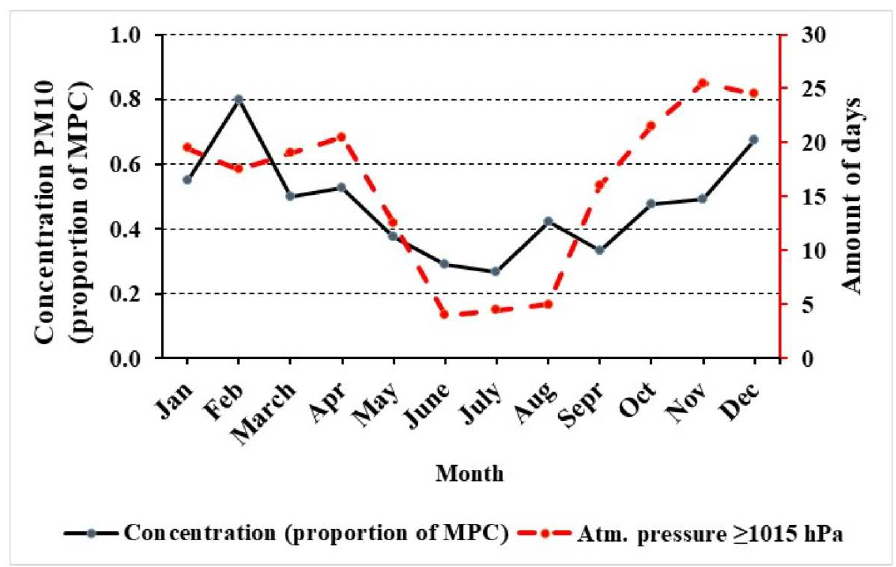
Figure 12. The annual variation of the average values of the PM 10 concentration (in proportion of MPC) and the number of days with atmospheric pressure equal to and above 1015 hPa.